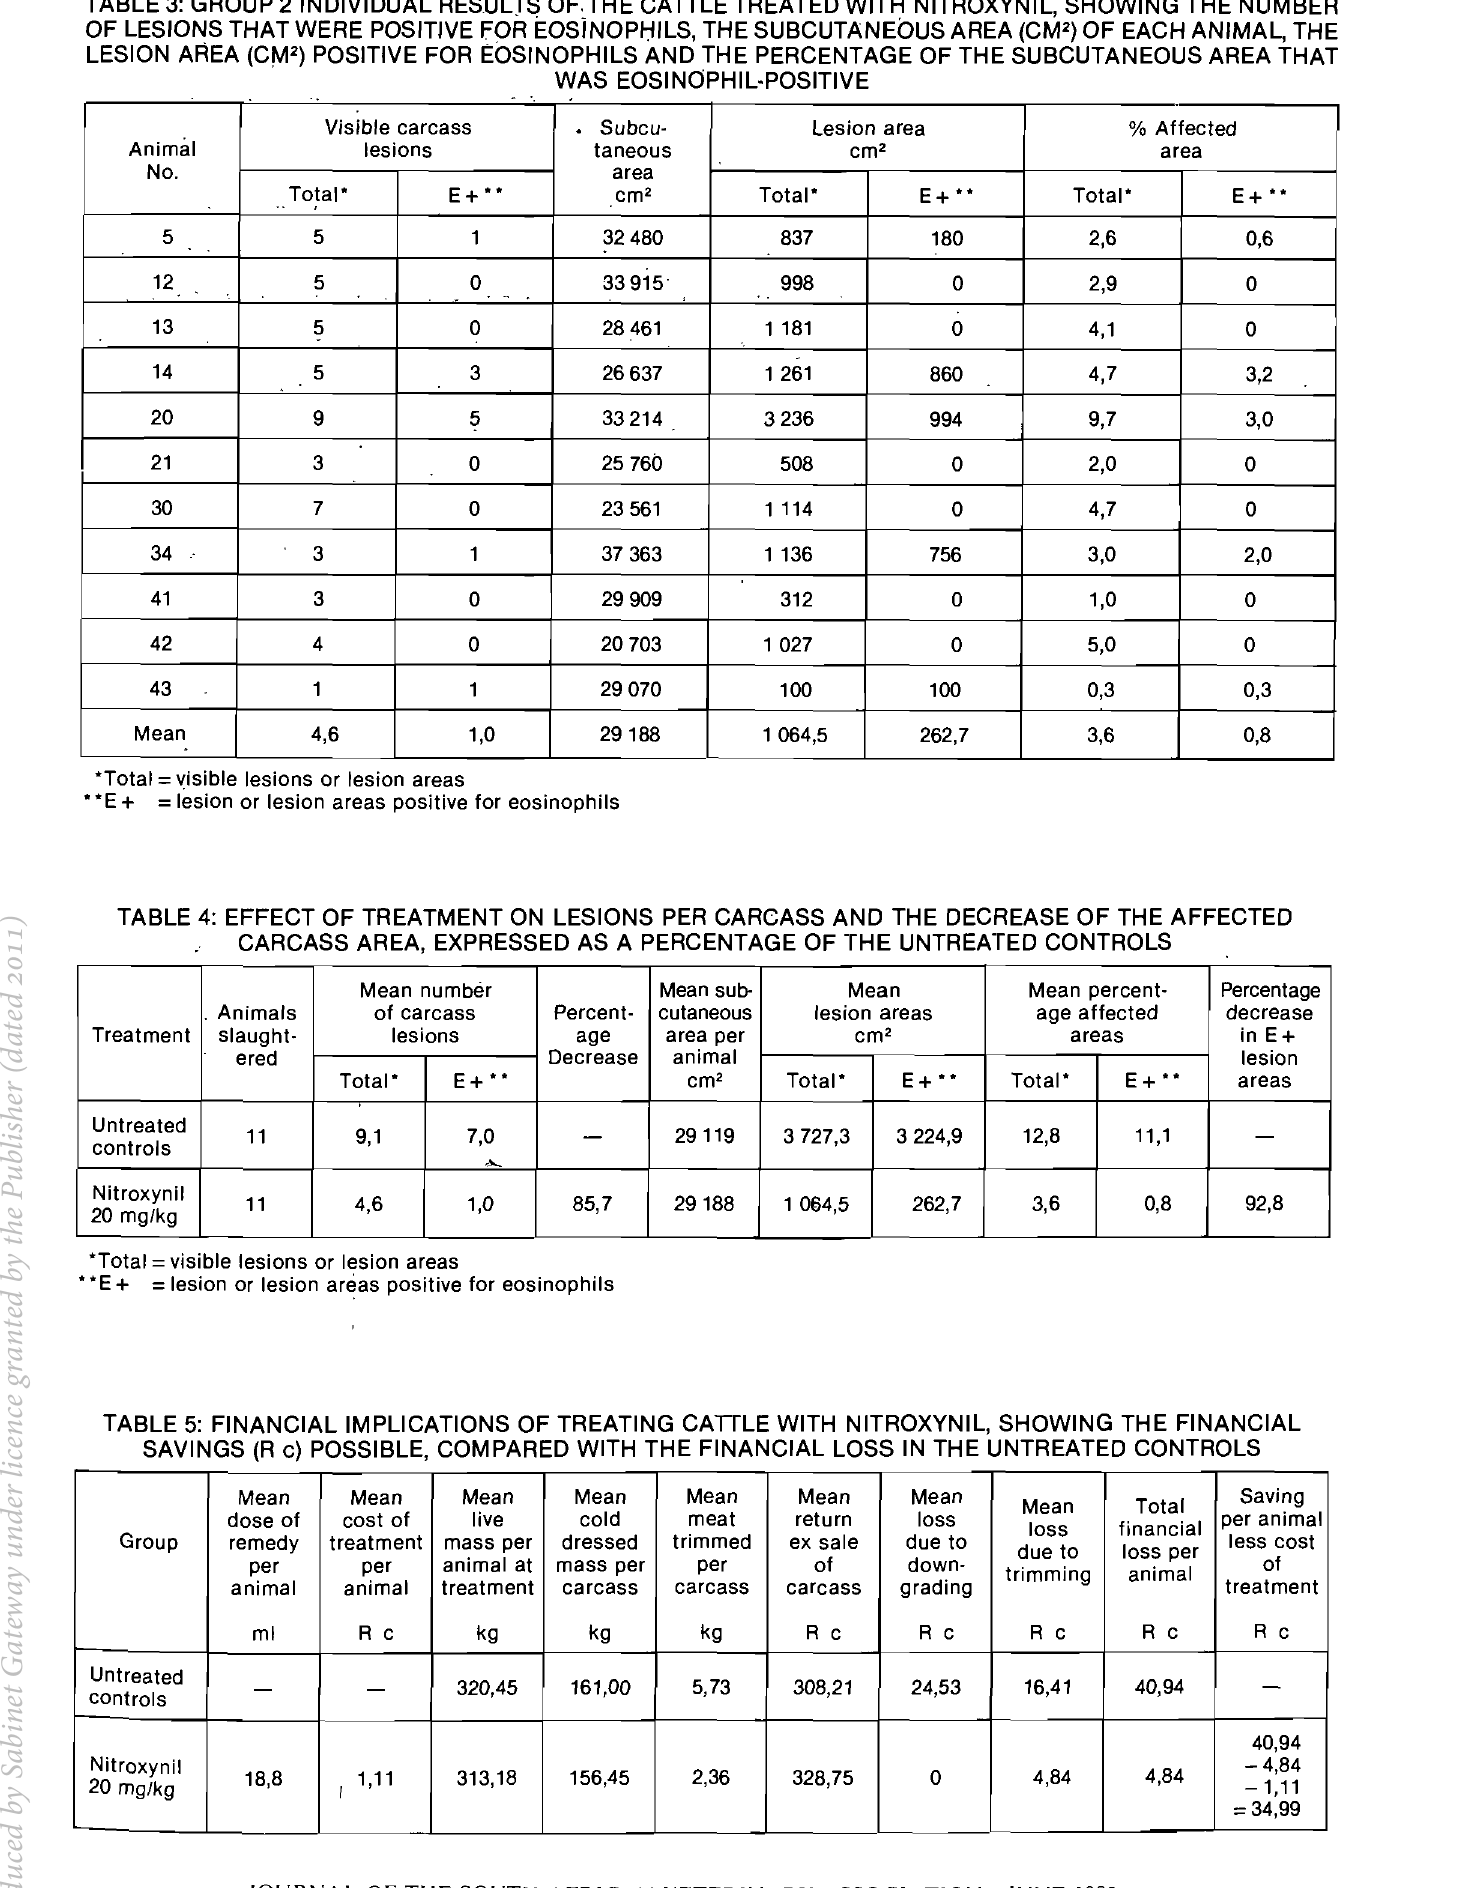
TABLE 3: GROUP 2 INDIVIDUAL RESULTS OF-THE CATTLE TREATED WITH NITROXYNIL, SHOWING THE NUMBER OF LESIONS THAT WERE POSITIVE FOR EosiNOPHILS, THE SUBCUTANEOUS AREA (CW) OF EACH ANIMAL, THE LESION AREA (CW) POSITIVE FOR ~OSINOPHILS AND THE PERCENTAGE OF THE SUBCUTANEOUS AREA THAT WAS EOSINOPHIL·POSITIVE '.